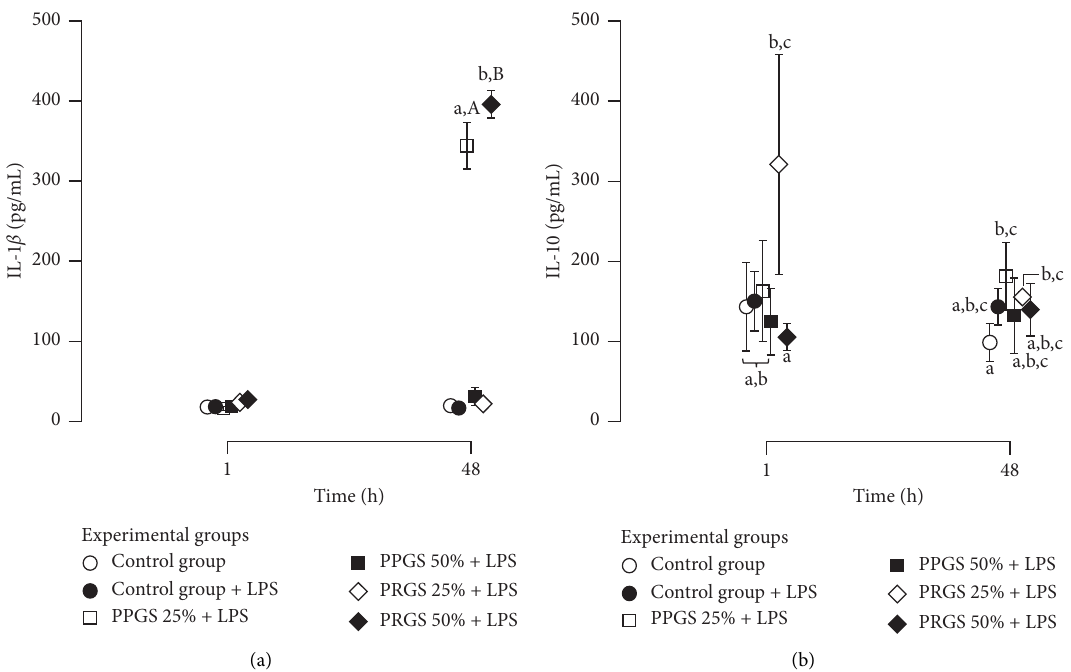
Figure 4: Cytokine concentrations in culture media from experimental groups at 1 and 48h (a). (a) Mean ( ± SD) IL-1 β concentrations (pg/ mL) (b) Mean ( ± SD) IL-10 concentrations (pg/mL). Different lower-case letters represent significant ( P < 0 . 01 ) differences between experimental groups at each independent time. Different capital letters represent significant ( P < 0 . 01 ) differences for the same experimental group at different times. HA, hyaluronan; IL, interleukin; LPS, lipopolysaccharide; PLT, platelet; PDGF-BB, platelet-derived growth factor isoform BB; PPP/PPGS, platelet-poor plasma/platelet-poor gel supernatant; PRP/PRGS, platelet-rich plasma/platelet-rich gel supernatant; TGF- β 1 , transforming growth factor beta 1; WBC, white blood